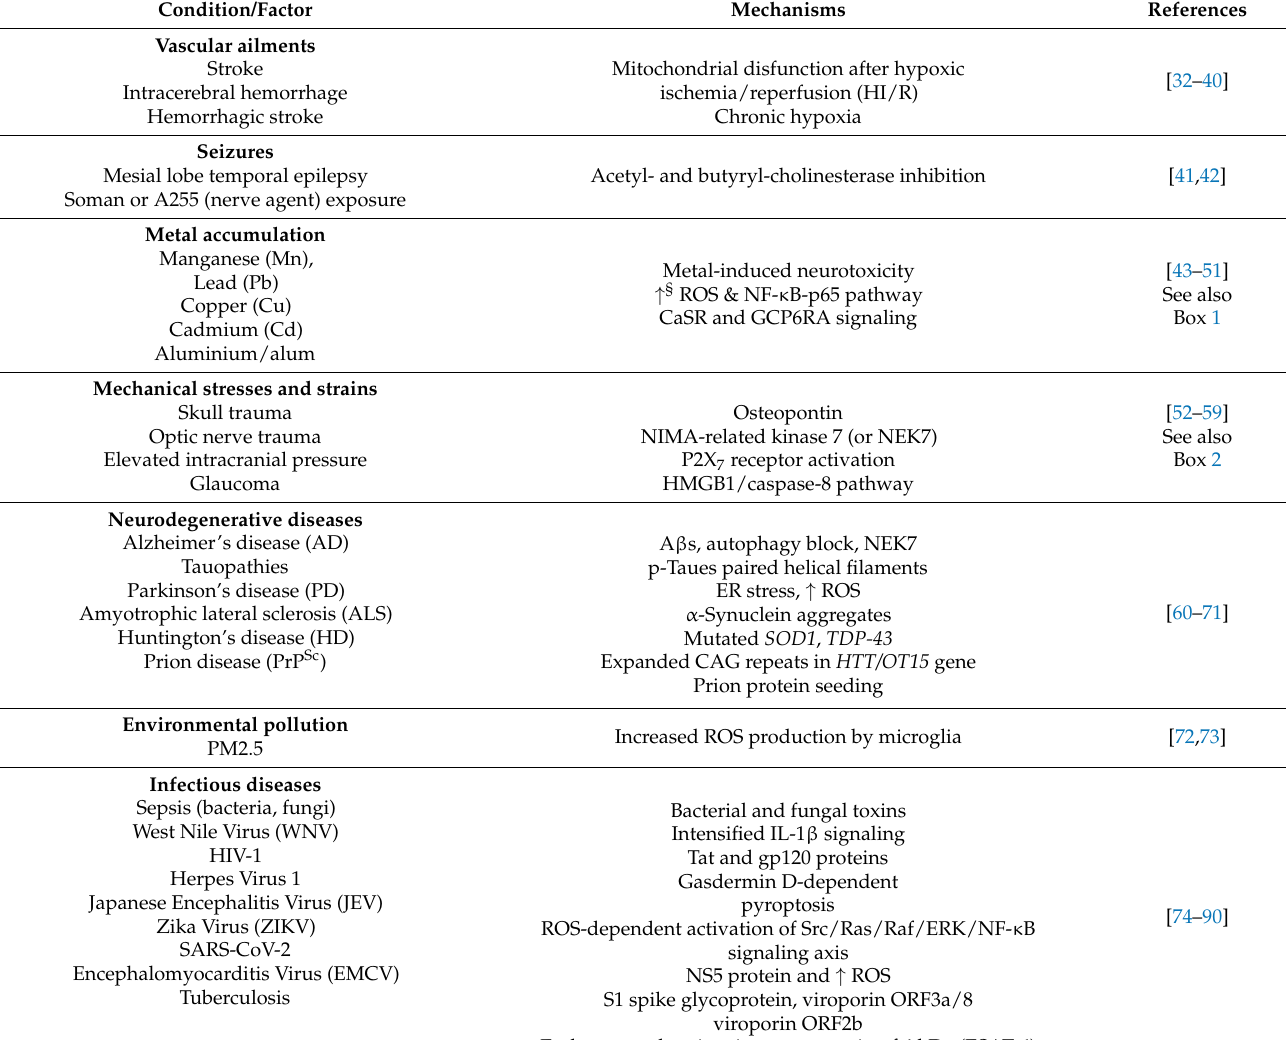
Table 1 lists the common brain NLRP3 inflammasome-activating diseases or agents. Table 1. Main conditions and factors activating the brain NLRP3